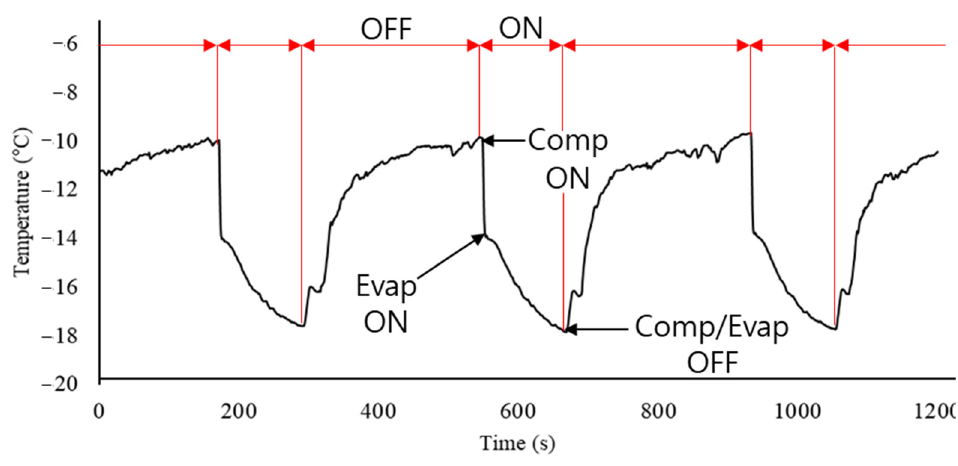
Figure 3. Change in supply air from the refrigeration